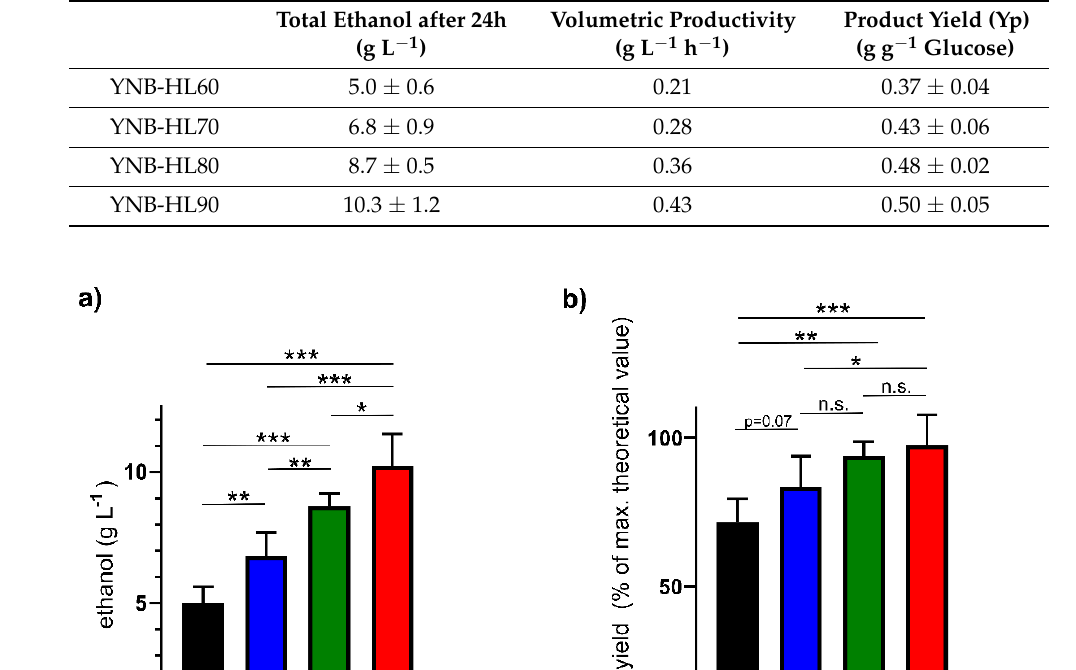
Table 1. Ethanol Production of I. orientalis KJ27-7.